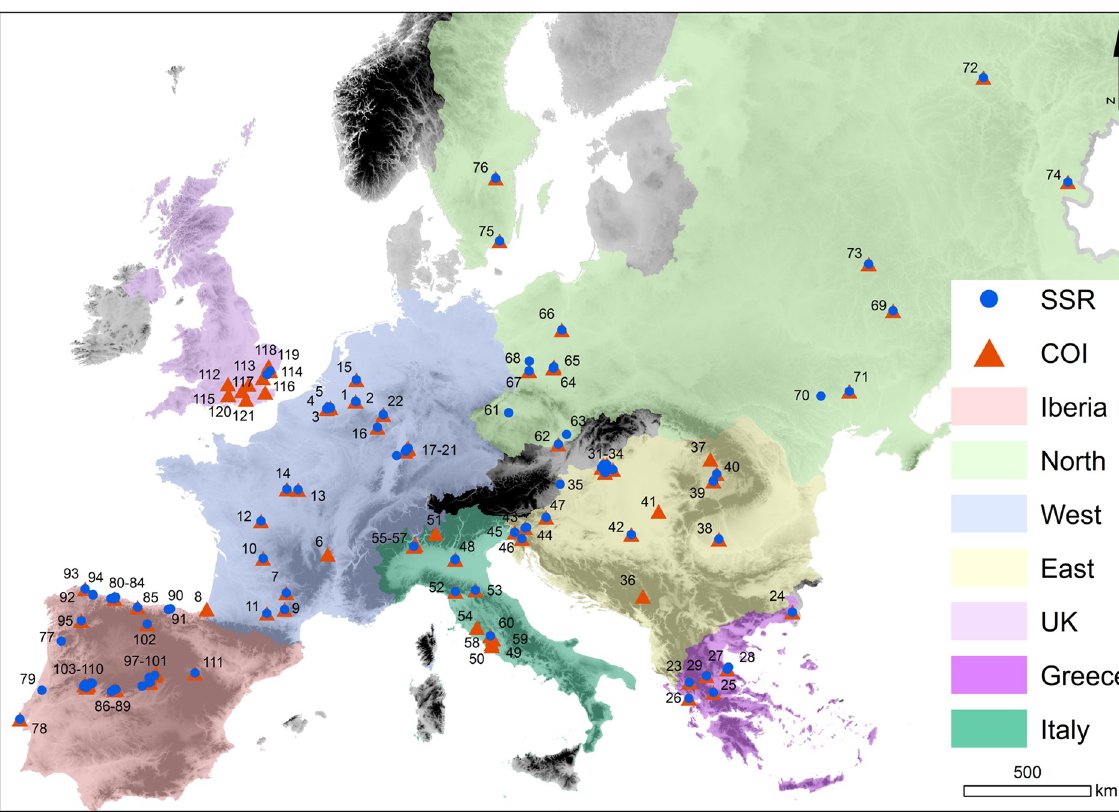
Fig 1. Sampling locations of Lucanus cervus . Localities with samples with COI sequences are indicated with orange triangles, those with samples genotyped with microsatellites with blue dots. The five regions over which the samples were divided are shown with different colours. The background is an altitude map of Europe in greyscale from the WorldClim database